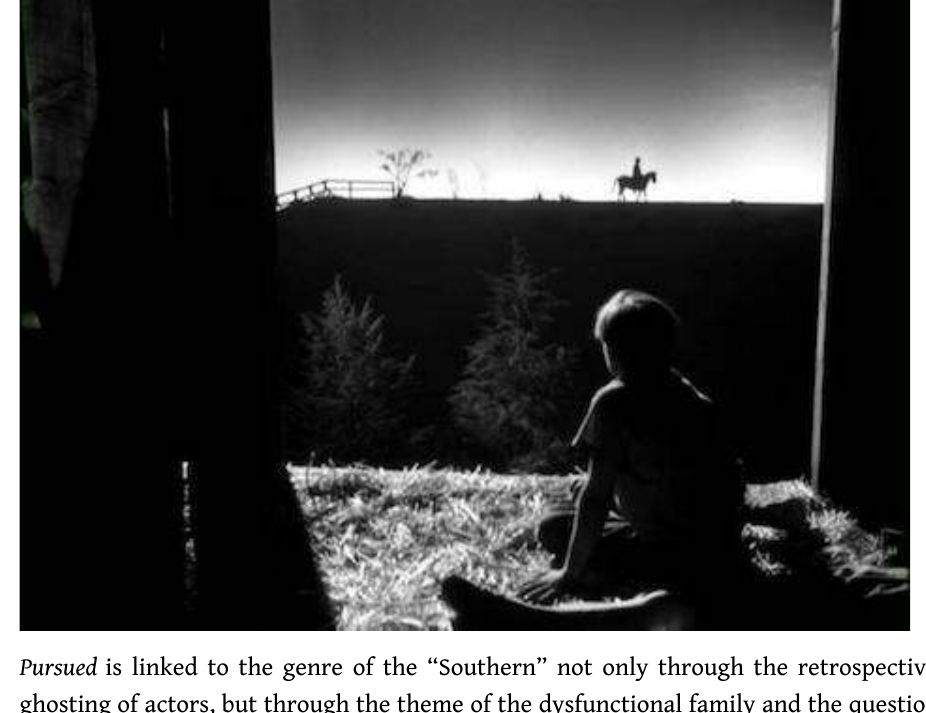
Figure 2: Mitchum tracking the children in The Night of the Hunter